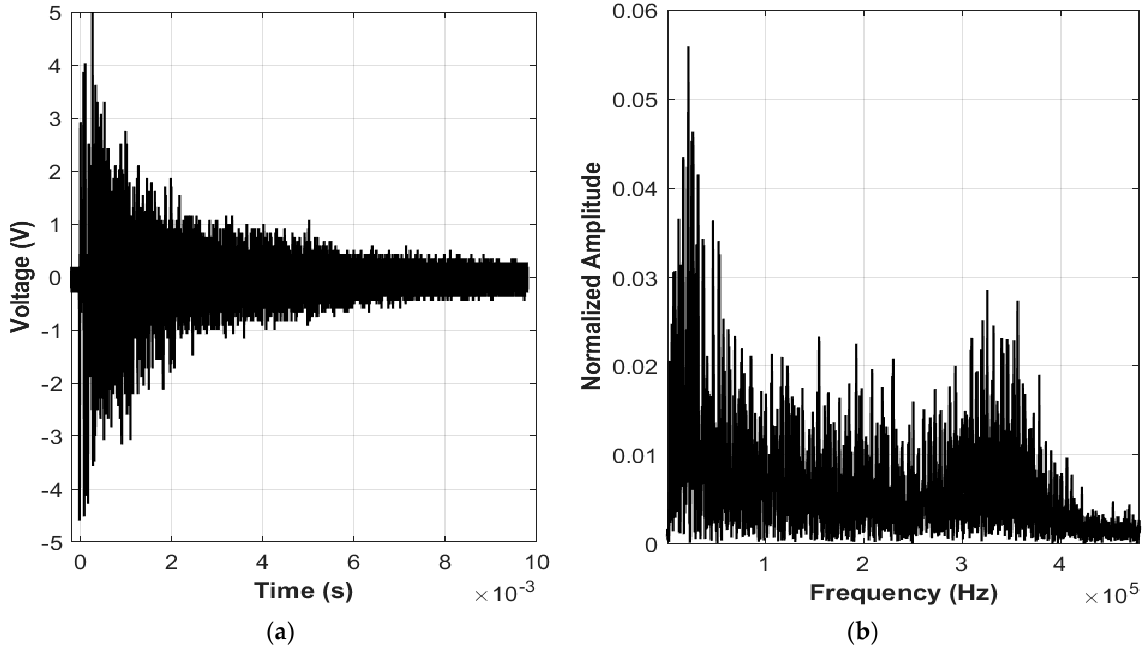
Figure 10. ( a ) Acoustic signal generated from a single laser pulse and ( b ) frequency spectrum of that acoustic signal.